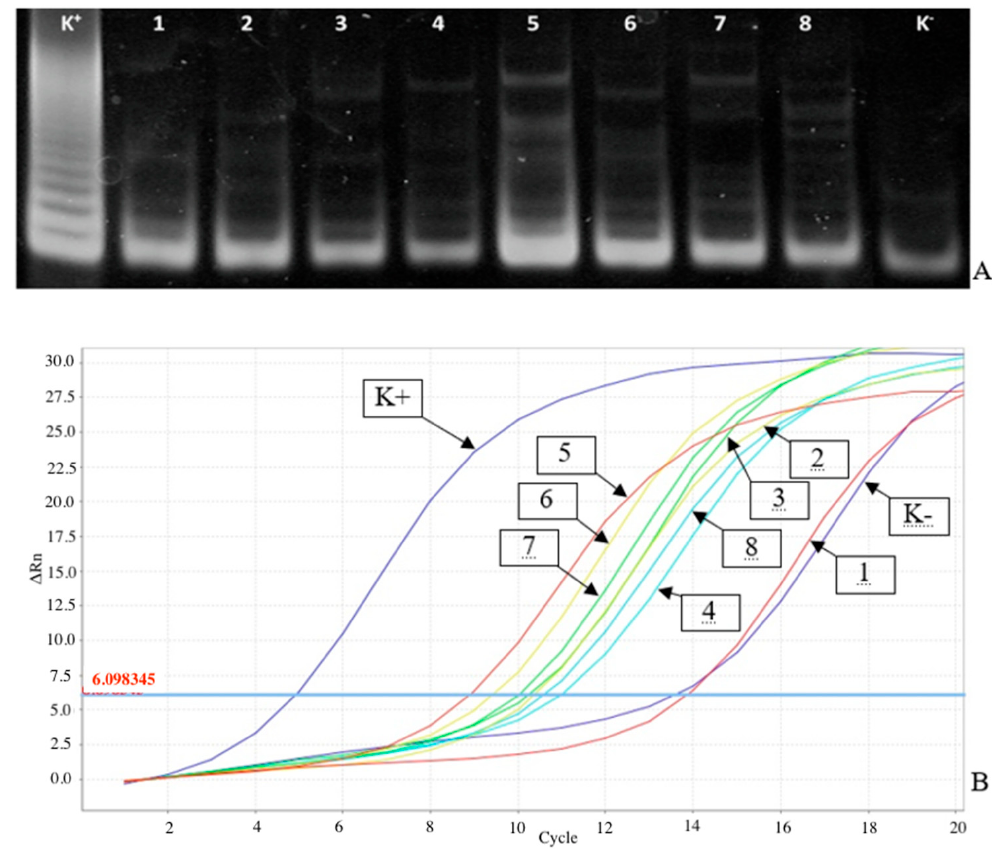
Figure 1. Telomerase activity (TA) analysis in tumor tissue and urine cell material samples from a patient with bladder cancer. TA analysis in a tumor tissue (tracks 1–4, A, and curves 1–4, B) and urine cell material (tracks 5–8, A, and curves 5–8, B) samples from a patient with bladder cancer. Reaction samples contained various amounts of lysate protein: 8 μ g (tracks 1, 5, A, and curves 1, 5, B), 4 μ g (tracks 2, 6, A, and curves 2, 6, B), 2 μ g (tracks 3, 7, A, and curves 3, 7, B), and 0.7 μ g (tracks 4, 8, A, and curves 4, 8, B). Track K − is a negative control sample (telomeric repeat amplification protocol (TRAP) in the absence of protein extract). Track K+ is a positive control (0.4 μ g of the K562 cell line extract). ( A ) Electrophoresis of TRAP-analysis products for TA detection. 10% PAAG, dyed with SYBR GOLD, UV photography. ( B ) Analysis of telomerase activity by RT-TRAP-2PCR. For